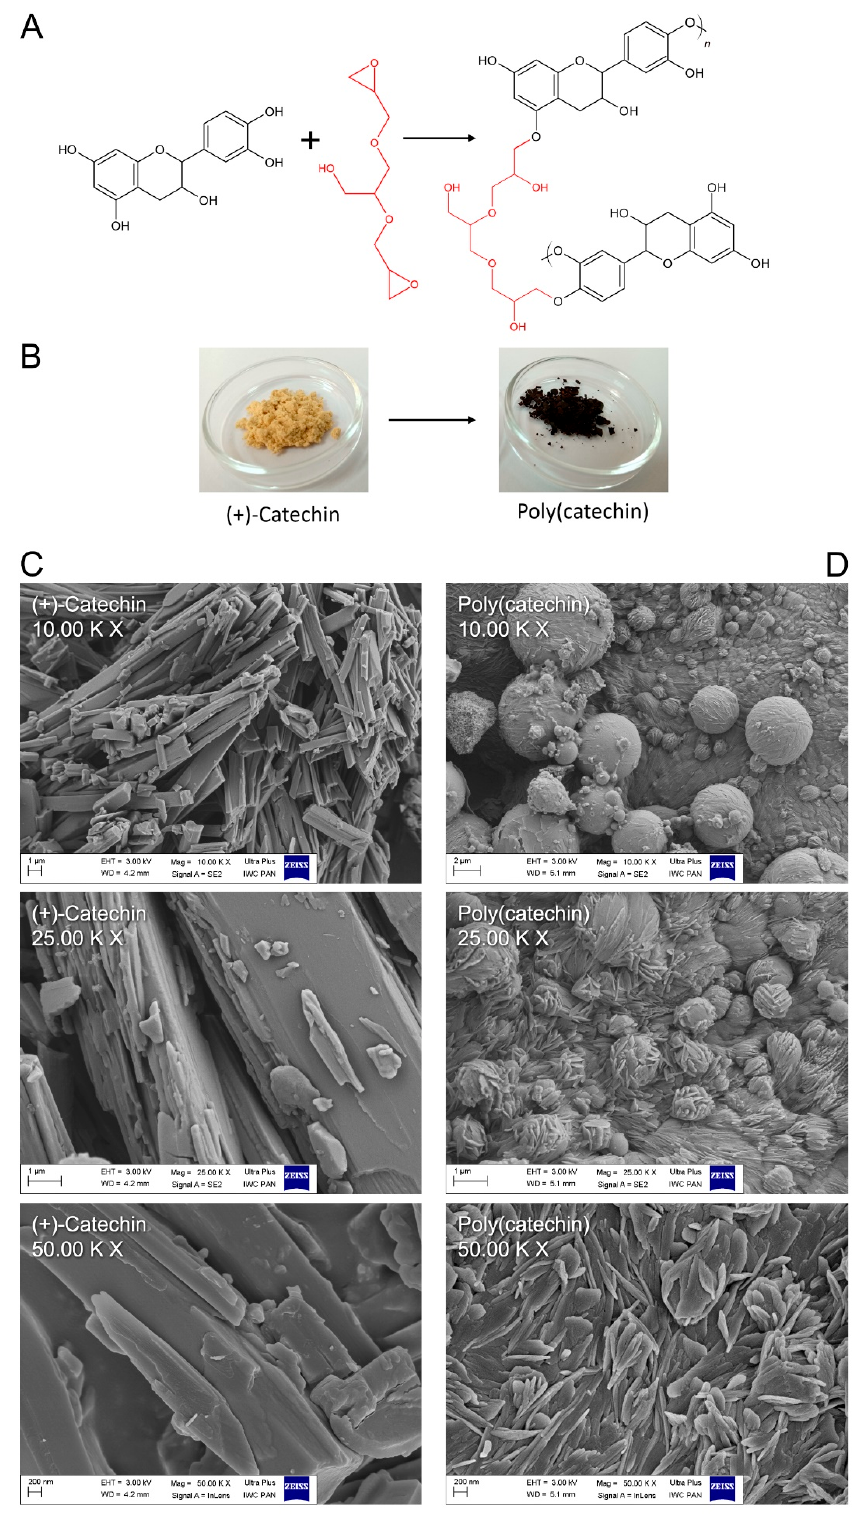
Figure 1. Scheme of the polymerization reaction of (+)-catechin with cross-linking compound ( A ); visual color change of (+)-catechin during polymerization with GDE (digital camera photos) ( B ); SEM images at 10.00 K X, 25.00 K X and 50.00 K X magnification of (+)-catechin ( C ) and poly(catechin) ( D ).